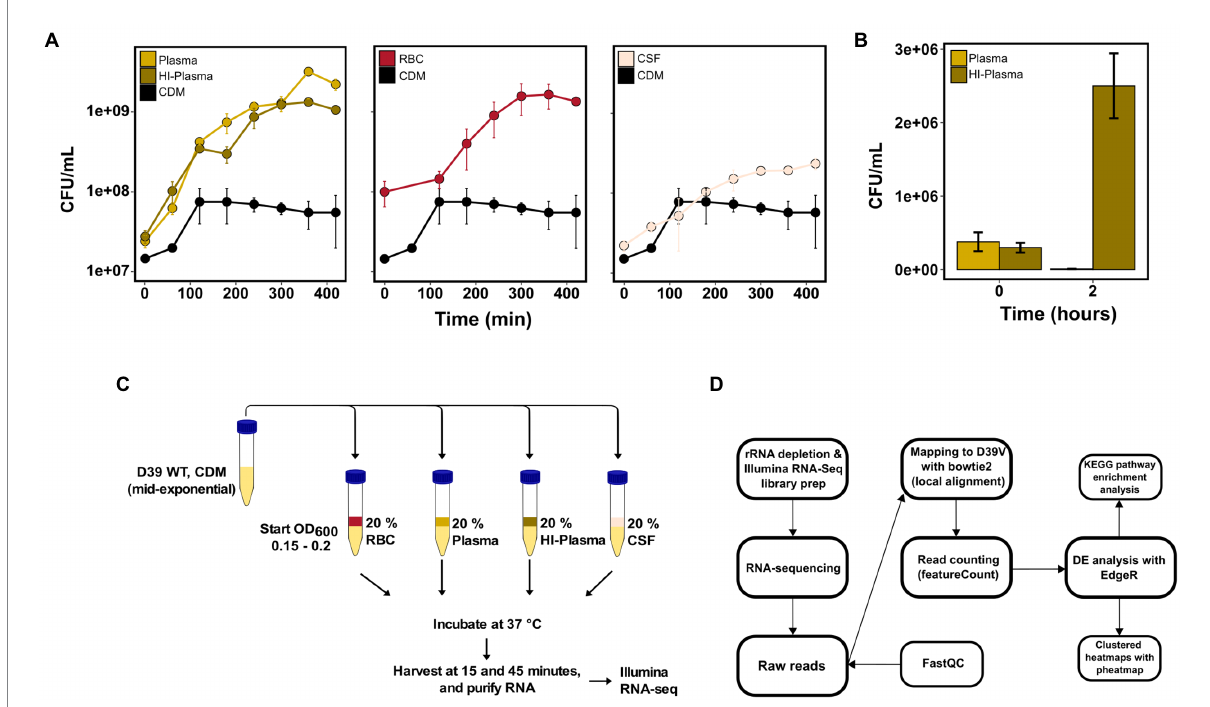
FIGURE 1 Pneumococcal in-vitro growth in invasive infection-associated human body fluids and RNA-sequencing workflow. (A) Mean CFU counts from 2 independent biological replicates of S. pneumoniae D39V grown in CDM compared to CDM supplemented with 20% pooled human plasma, heat- inactivated plasma (HI-plasma), red blood cells (RBC) or cerebrospinal fluid (CSF). Error bars represent standard deviations. (B) Heat-inactivation of plasma was validated by a plasma survival assay of the serum-sensitive E. coli NU14. Each bar represents mean CFU of E. coli after 0 or 2 h of incubation in 20% plasma and HI-plasma from 3 independent biological replicates. Error bars represent standard deviation. (C) For RNA- sequencing, S. pneumoniae D39V was grown in 20% plasma, HI-plasma, RBC, and CSF for 15 and 45 min before harvest. (D) Paired-end Illumina RNA-sequencing and analysis was carried out as described in the